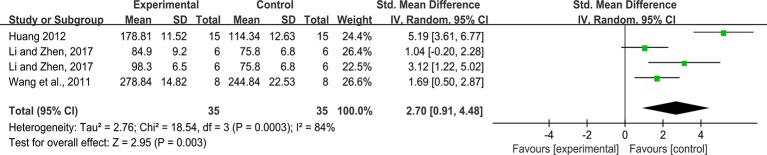
Pooled estimate of SOD with rhein.